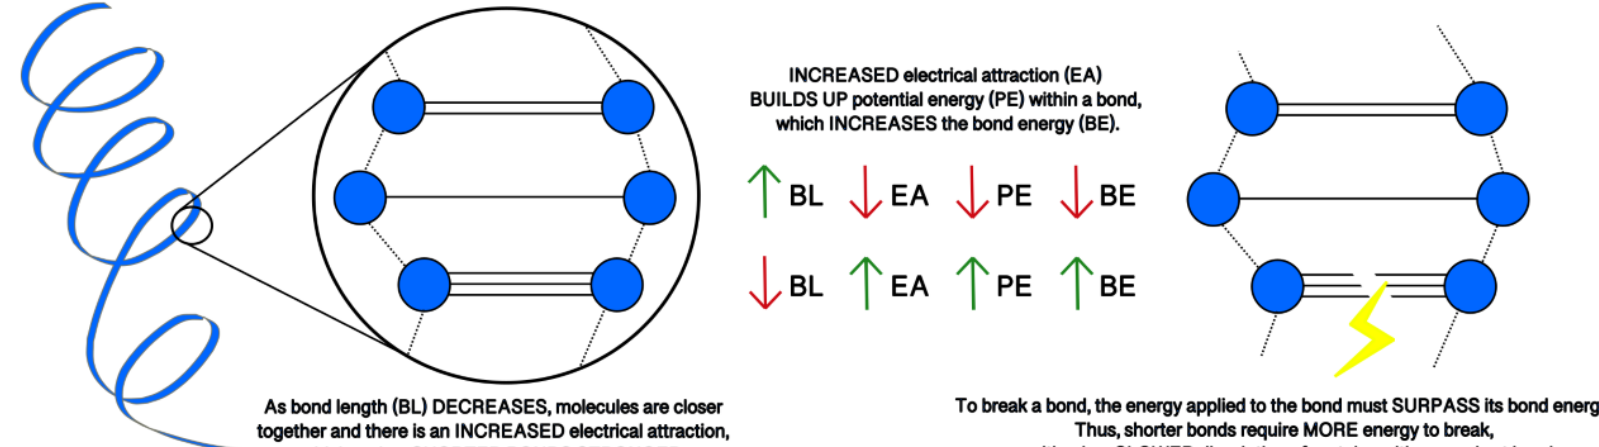
Figure 45. Structure of biomarkers and kinetics relationship.